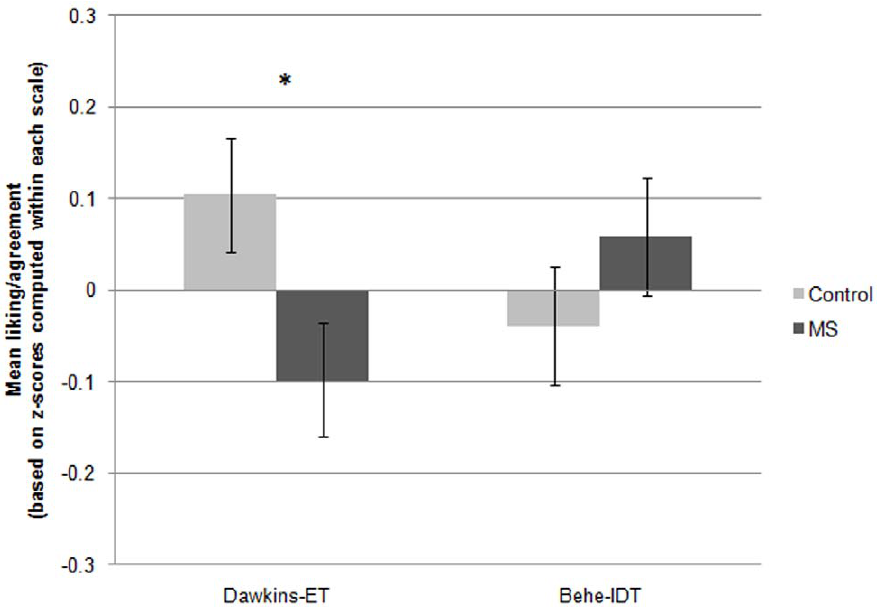
Figure 2. Effects of MS on liking of Behe and belief in IDT, and liking of Dawkins and belief in ET, Study 2. Note . Values are based on standard scores; means for each scale were computed by standardizing each of the six author-theory items that the scale comprised, around their common mean, and taking the mean of the resulting z-scores. Because the two scales were centered around different means, values on the two scales (Dawkins-ET and Behe-IDT) cannot be directly compared to each other. The overall interaction, which emerged from a mixed-measures analysis of variance (ANOVA), and the difference between the control and MS conditions on Dawkins-ET, based on a t -test, was significant, p , .05. Error bars represent the standard error of the mean. * p , .05.